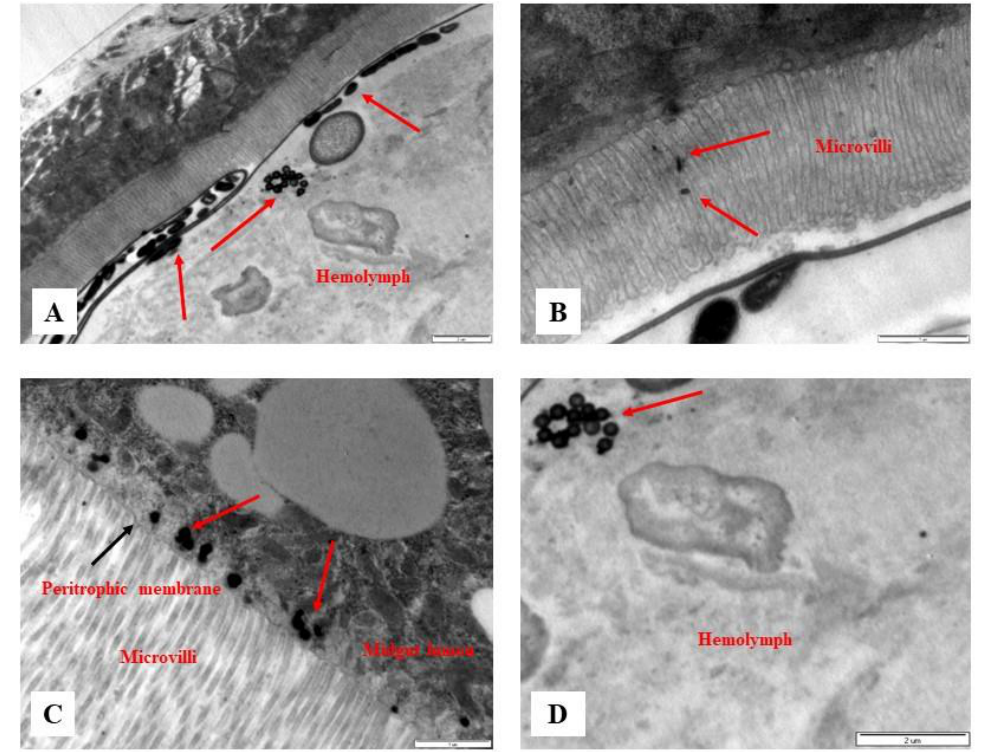
Figure 2. Images of ingested PSMPLs (4 µ m) from their ingestion until their translocation to the hemolymph. PSMPLs (4 µ m) are attached to the peritrophic membrane ( A ), inside the microvilli ( B ), distributed into the midgut lumen ( C ), and ultimately, reaching the hemolymph ( D